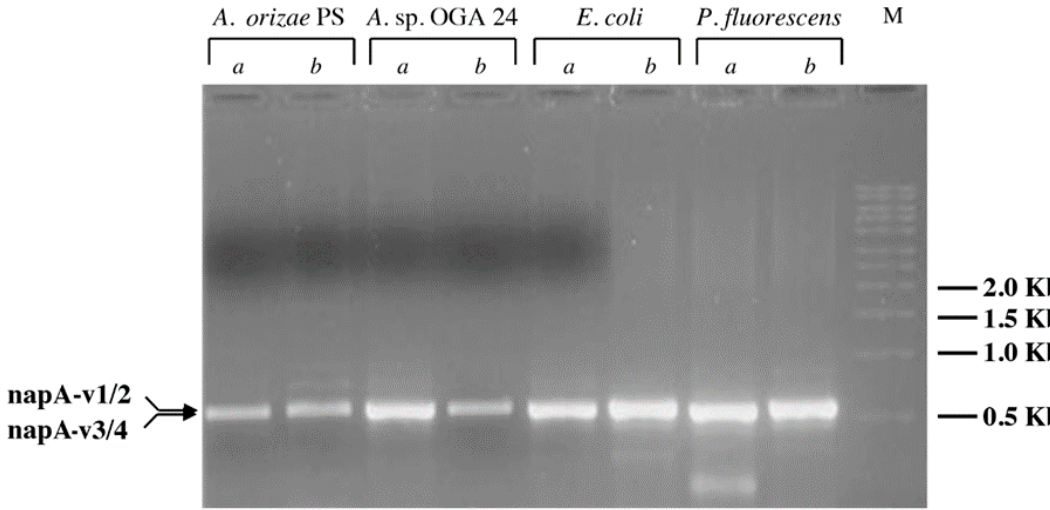
Figure 2. PCR analysis of large subunit of periplasmic nitrate reductase ( nap A). Lanes a and b indicate amplification by nap-v 1 / 2 and nap-v 3 / 4, respectively. M: molecular marker. Escherichia coli , Pseudomonas fluorescens, and A. oryzae PS were used as positive control. Expected length for PCR fragments: 591 bp for nap-v 1 / 2 and 541 bp for nap-v 3 / 4.